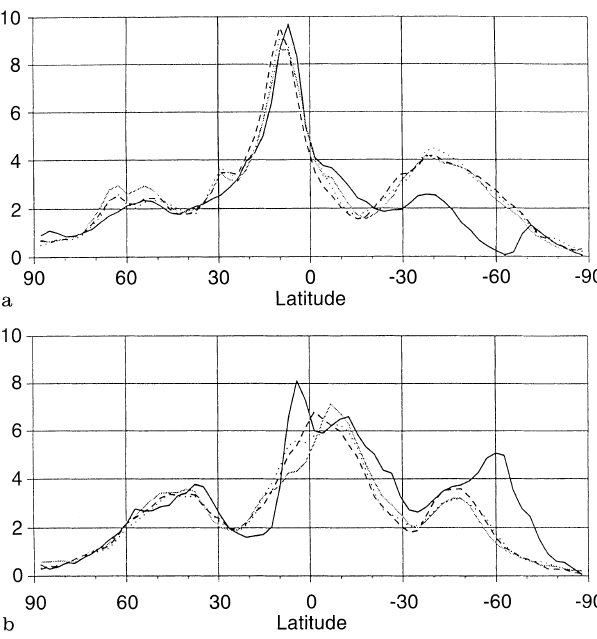
Fig. 11a, b. Zonal mean precipitation (mm day (cid:255) 1 ) for a July and b January GWD31 ( thin solid ), GWDT41 ( dashed ), GWDS41 ( dotted ) and climatology ( thick